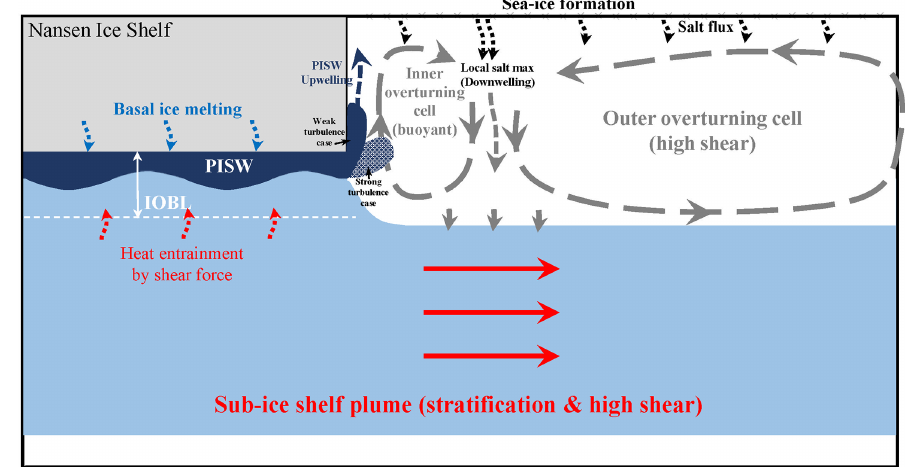
Figure 10. Final conclusions and schematic diagram representing the oceanographic picture near the NIS front and the various phenomena that occur within the IOBL, as resolved via